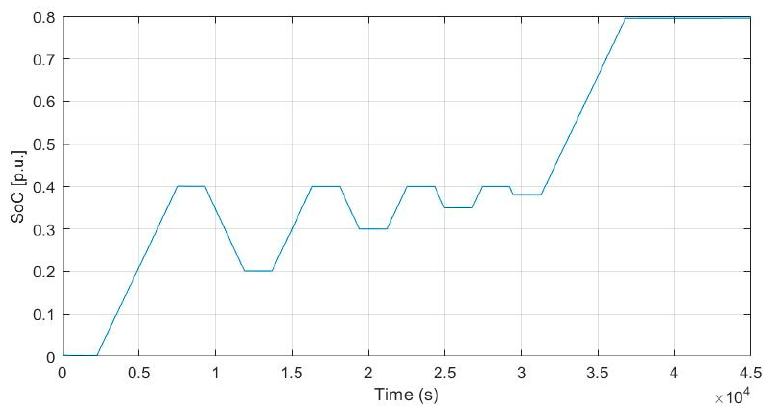
Figure 15. Scheduling of the test for hysteresis modeling.